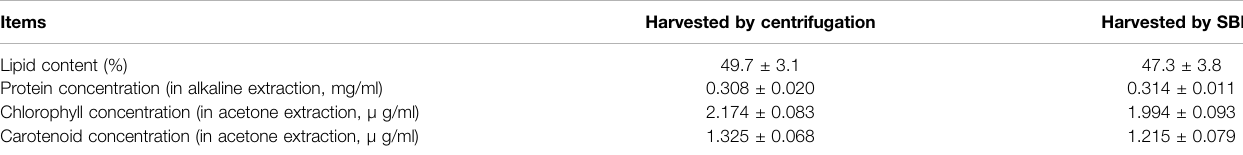
TABLE 2 | In fl uence of SBEF on microalgae metabolites: lipids, proteins, chlorophyll, and carotenoids. Items Harvested by